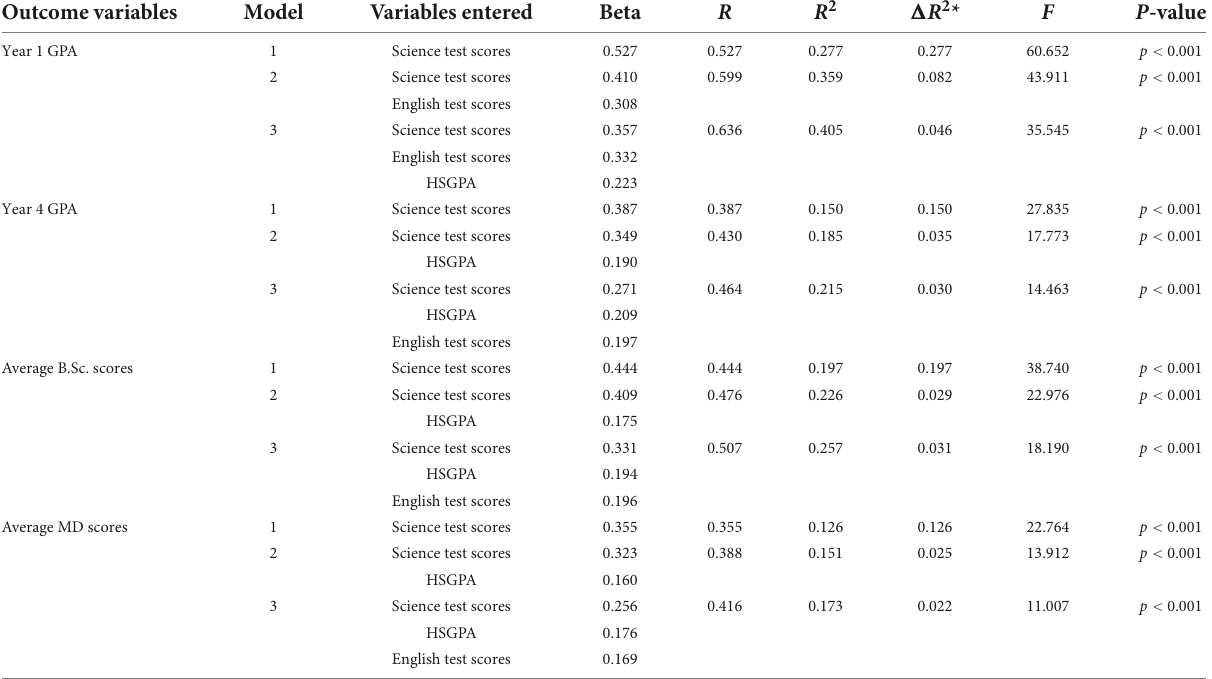
TABLE 5 Summary of stepwise regression analyses of predicting academic performance ( n = 160). Outcome